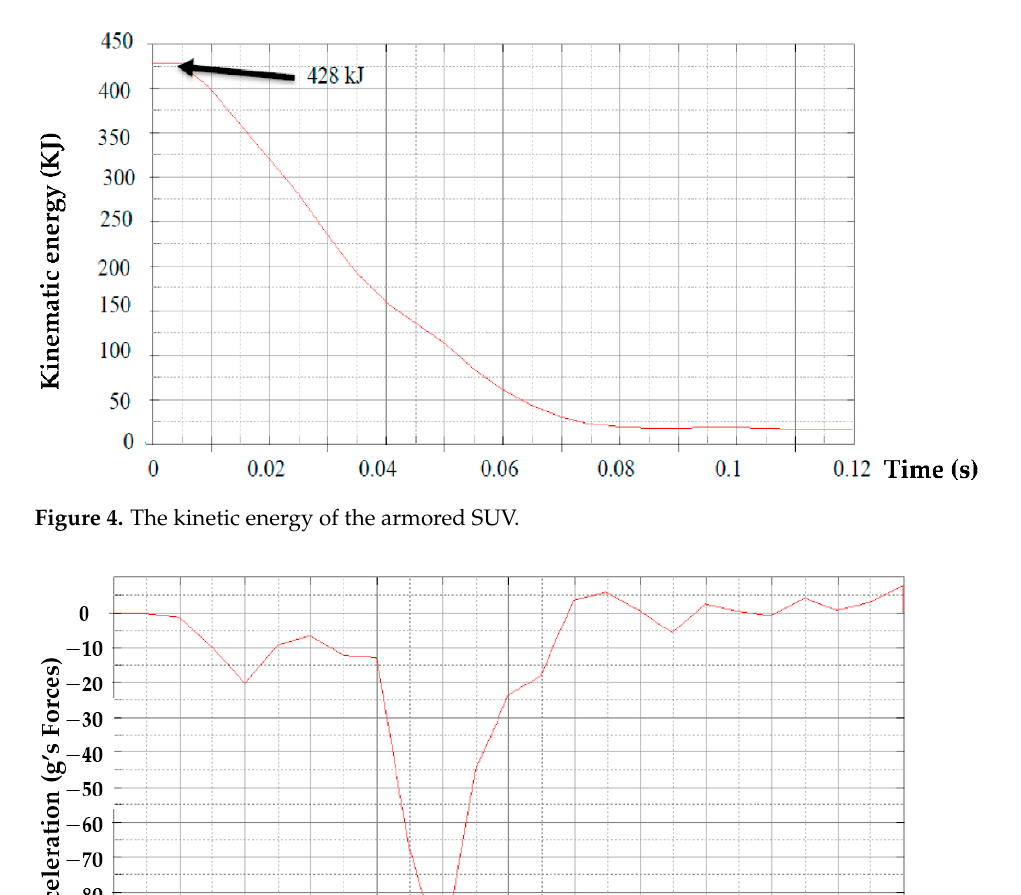
Figure 4. The kinetic energy of the armored SUV.